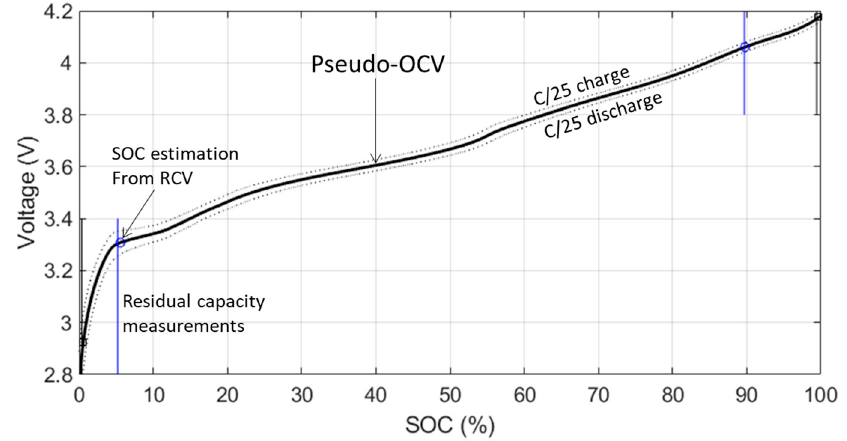
Figure 6. The C/25 charge and discharge curves and associated pseudo-open circuit voltage (OCV) curve. Black squares and blue circles indicate the state-of-charge (SOC) estimated from C/3 and C/25 rest cell voltages, respectively. Vertical lines indicate the amount of additional capacity added by the residual capacity steps.